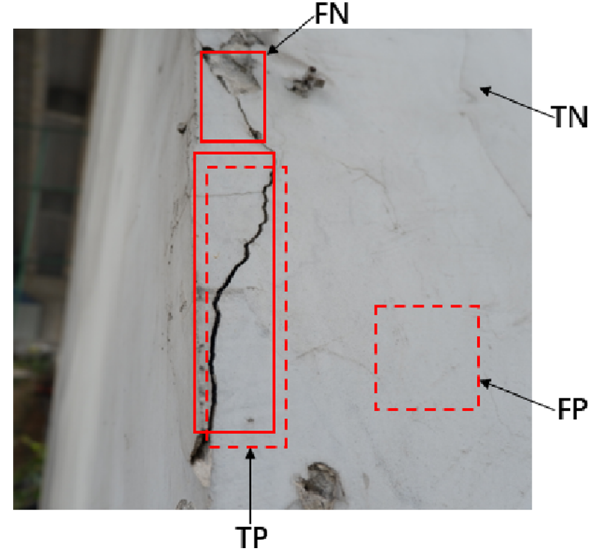
Fig. 8 Example of positive and negative sample discrimination